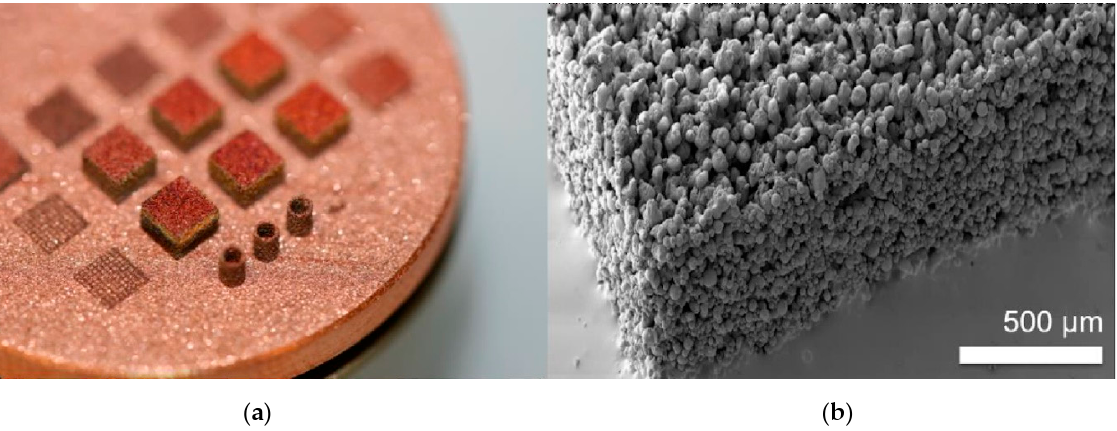
Figure 11. ( a ) The samples fabricated with cuboids of a 2 × 2 mm 2 size, and total height of 1.4 mm; ( b ) SEM images of the sample (Adapted from reference [54]).